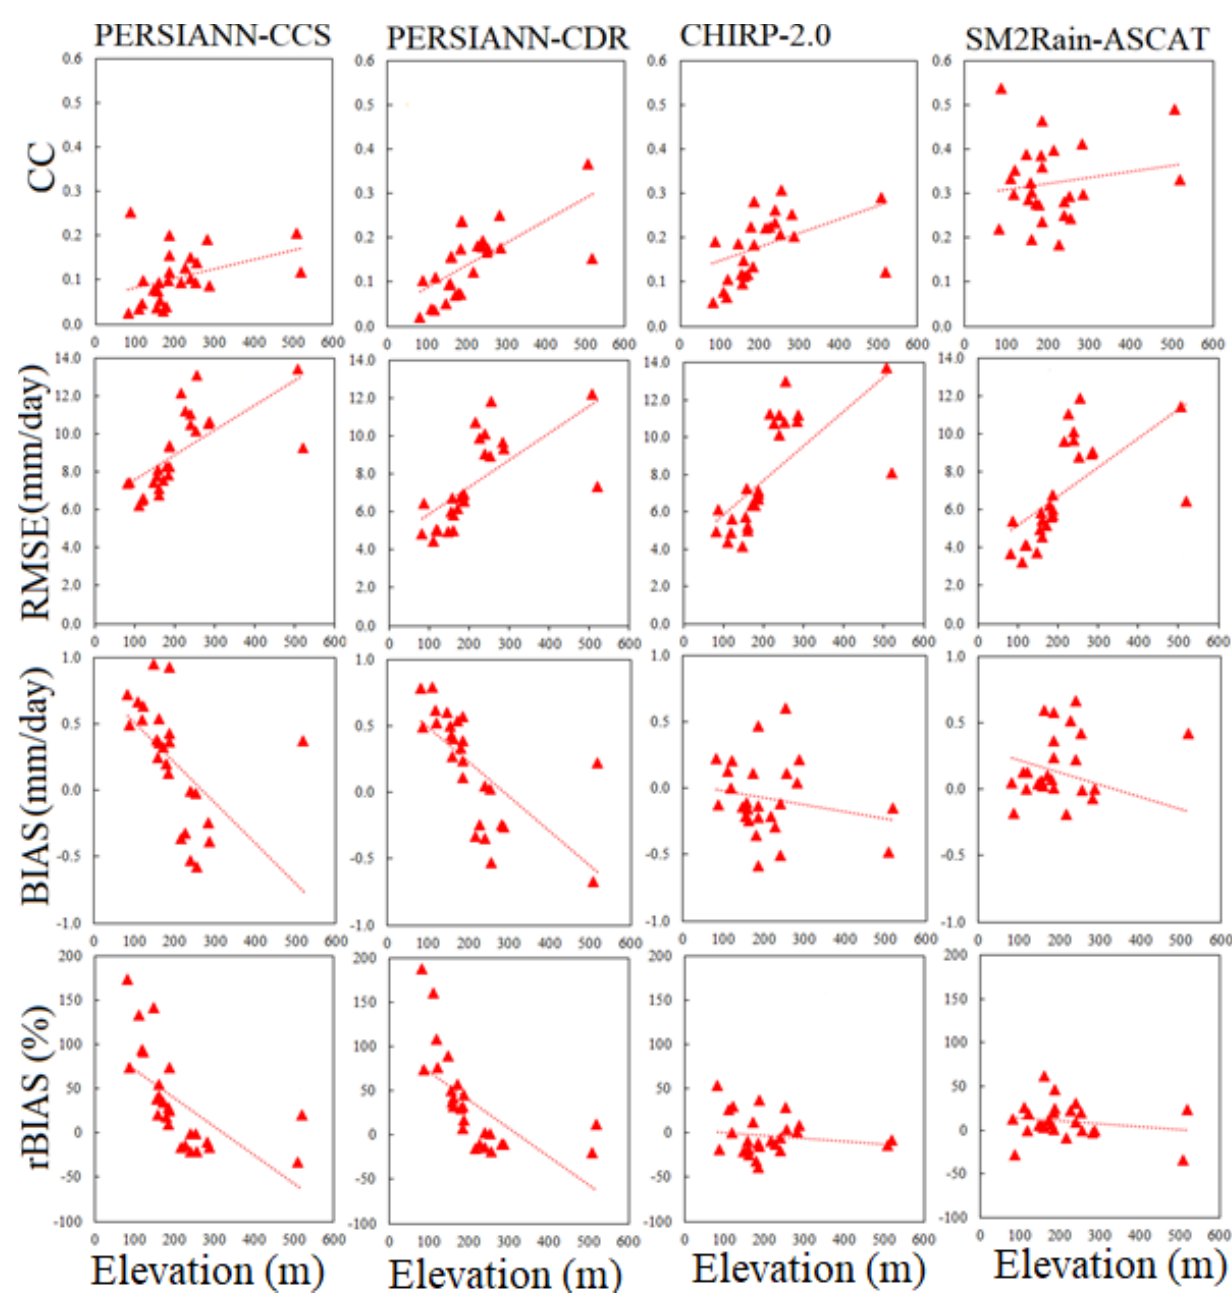
Figure 8. Scatter plots of assessment indices versus elevation on the daily scale.